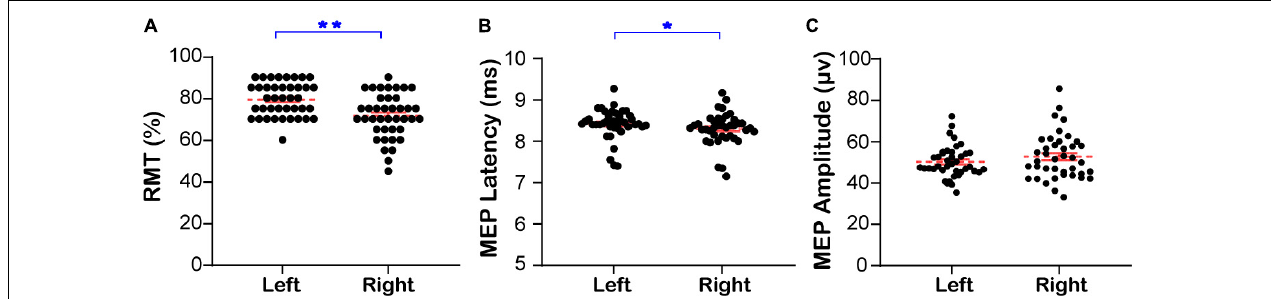
FIGURE 1 | The RMT and MEP of the contralateral mylohyoid innervated by the bilateral swallowing motor cortices. (A) The bilateral resting motor threshold. (B) The bilateral latency of motor evoked potential. (C) The bilateral amplitude of motor evoked potential. Left: The RMT and MEP of the contralateral mylohyoid innervated by the left swallowing motor cortex; Right: The RMT and MEP of the contralateral mylohyoid innervated by the right swallowing motor cortex; RMT, resting motor threshold; MEP, motor evoked potential;* P < 0.05, ** P <